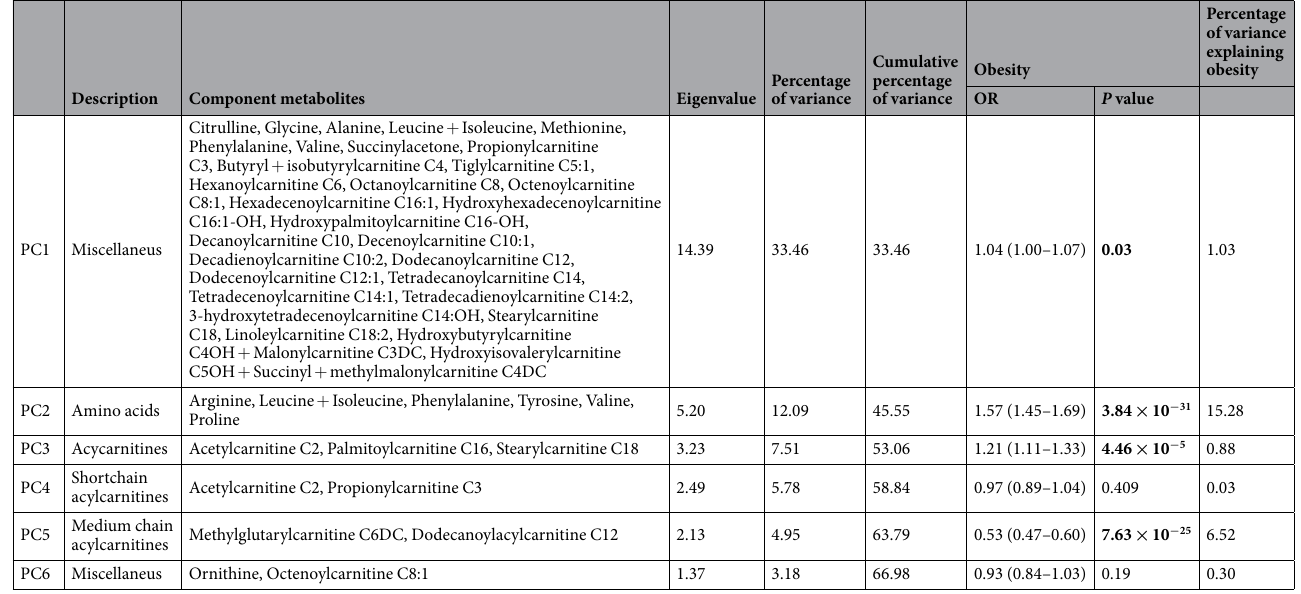
Table 1. Principal component analysis of 42 metabolites and associations of clusters with obesity in a case-control cohort of Mexican school-age children. The logistic regression model was adjusted for gender and age.Significant P-values are shown in